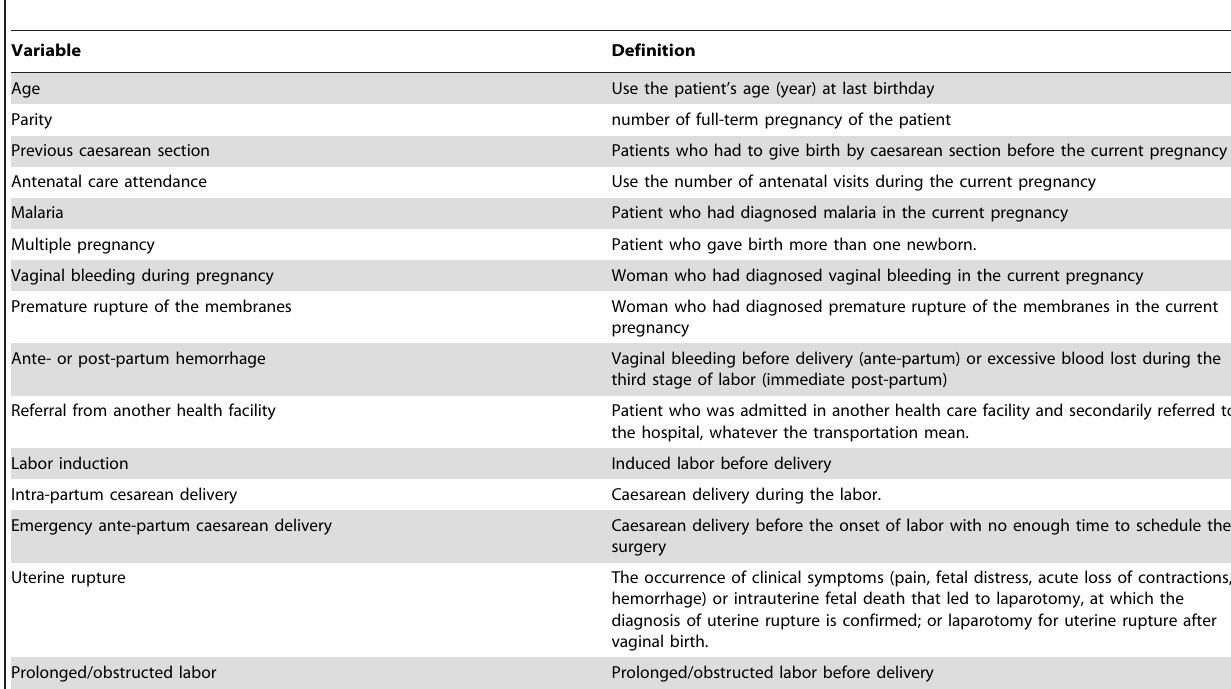
Table 3. Definitions of the variables included in the association classification rules.